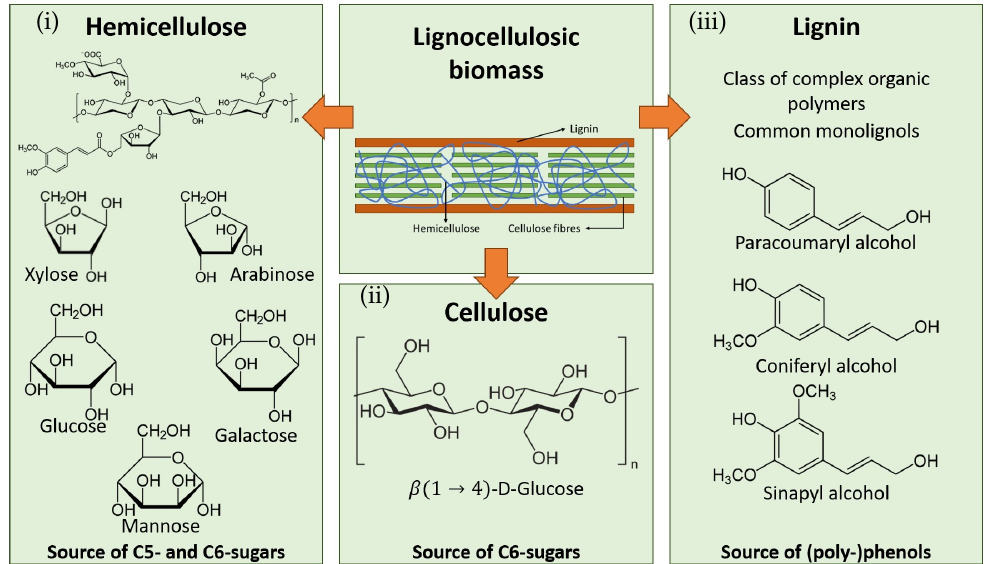
Figure 1. Schematic representation of lignocellulosic biomass and its three main building-blocks: (i) hemicellulose, (ii) cellulose and (iii) lignin (taken from